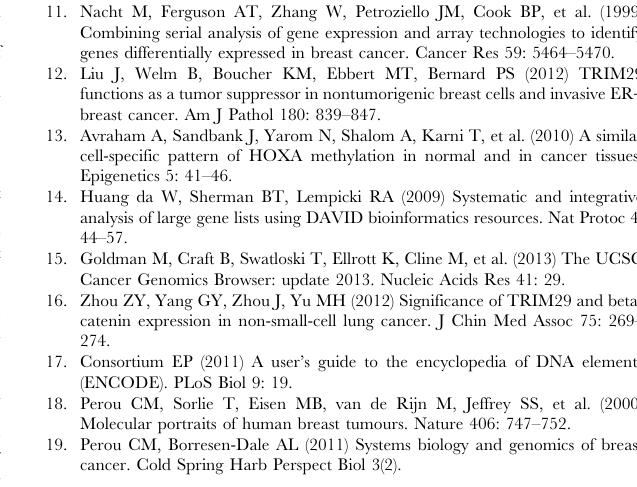
probes as compared breast to colon, endometrial and lung epithelial tissues. Table S1 List of Illumina probes and corresponding genes that were differentially methylated in breast epithelium as compared to colon, lung and endometrial epithelium: Illumina methylation array analysis. Table S2 A. DAVID results: functional classification of 110 genes that had unique methylation in breast epithelium. B. Detailed description of members in the DNA binding and transcription regulators subgroup. Table S3 Genes differentially methylated in normal breast, DNA binding and transcription regulator sub- group: A comparison with methylation in the respective carcinomas, TCGA analysis. Table S4 TRIM29 CpG island genomic sequence, TRIM29 Illumina probes details and primer sequences